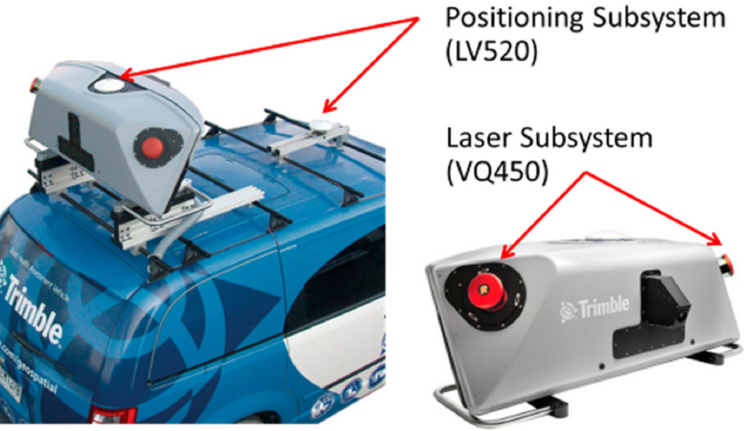
Figure 1. Mobile mapping 3D laser scanner